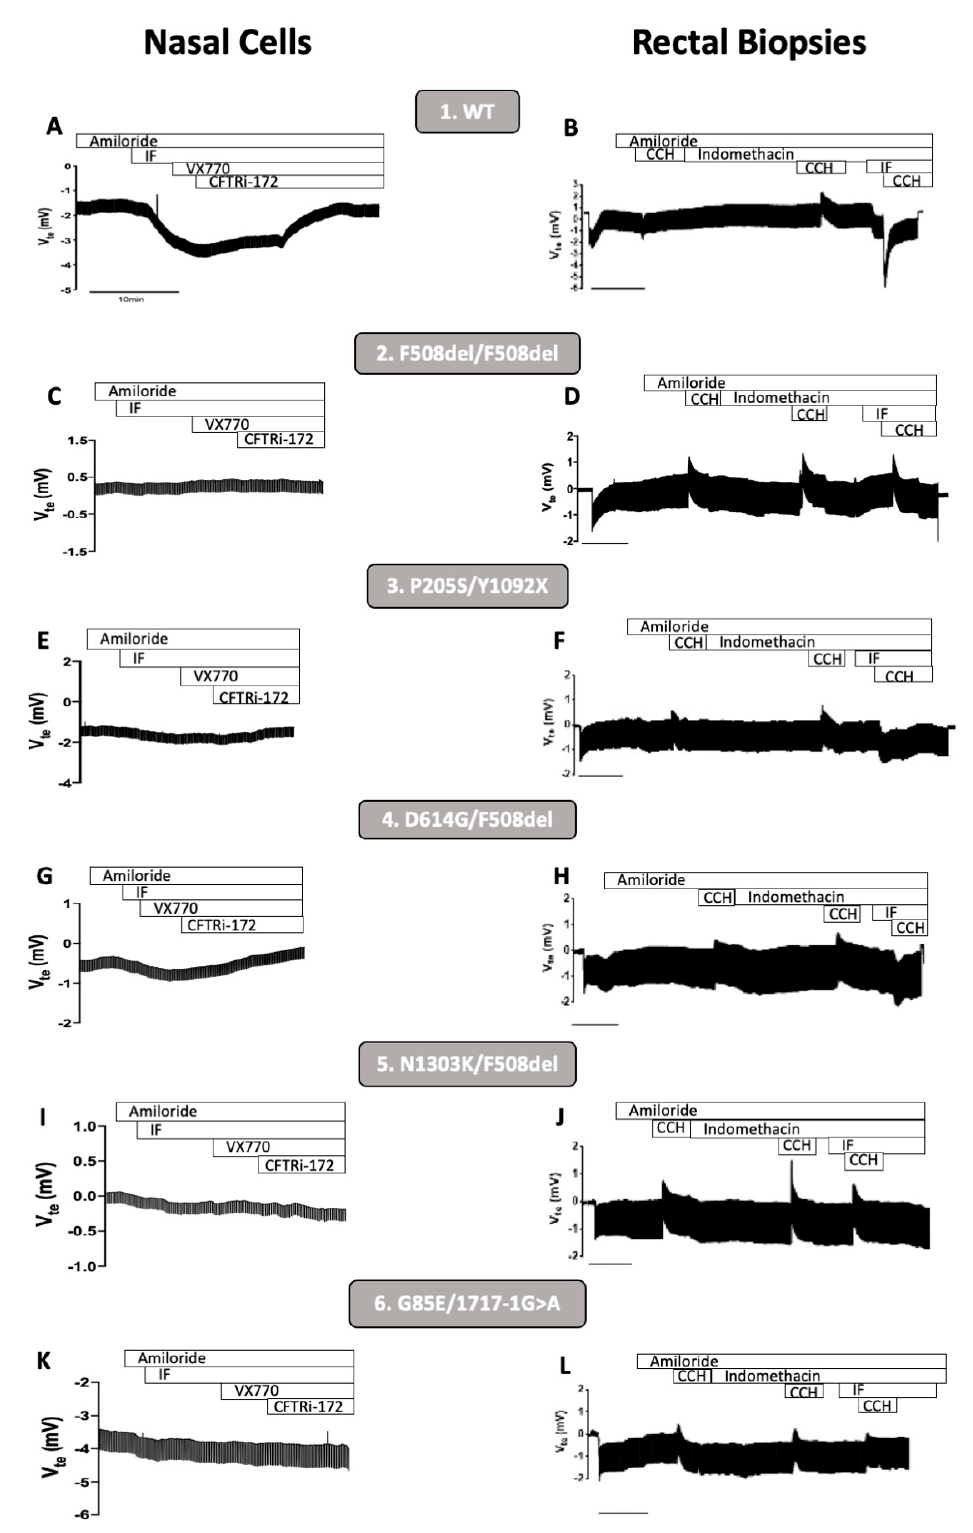
Figure 1. Comparison of basal CFTR-mediated Cl − secretion in primary human nasal epithelial cells (pHNEs) and rectal biopsies. Measurements of basal CFTR-mediated Cl − secretion in pHNEs (left panels) in samples from one healthy